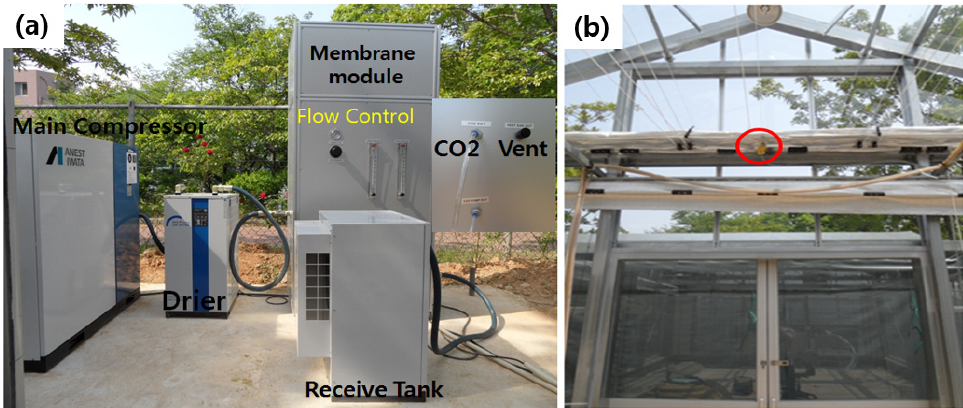
Figure 5. Membrane module and CO 2 supply systems: ( a ) Membrane function; ( b ) carbon dioxide inlet.